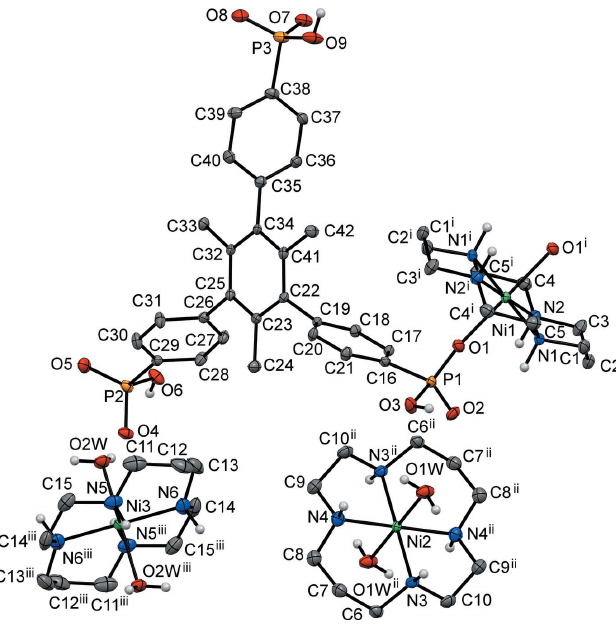
Figure 1 The extended asymmetric unit in I showing the coordination environment of the Ni atoms and the atom-labeling scheme (displacement ellipsoids are drawn at the 30% probability level). C-bound H atoms and uncoordinated water molecules are omitted for clarity. Symmetry codes: (i) (cid:3) x + 2, (cid:3) y + 1, (cid:3) z + 2; (ii) (cid:3) x + 2, (cid:3) y + 2, (cid:3) z + 1; (iii) (cid:3) x + 1, (cid:3) y + 3, (cid:3) z + 1.